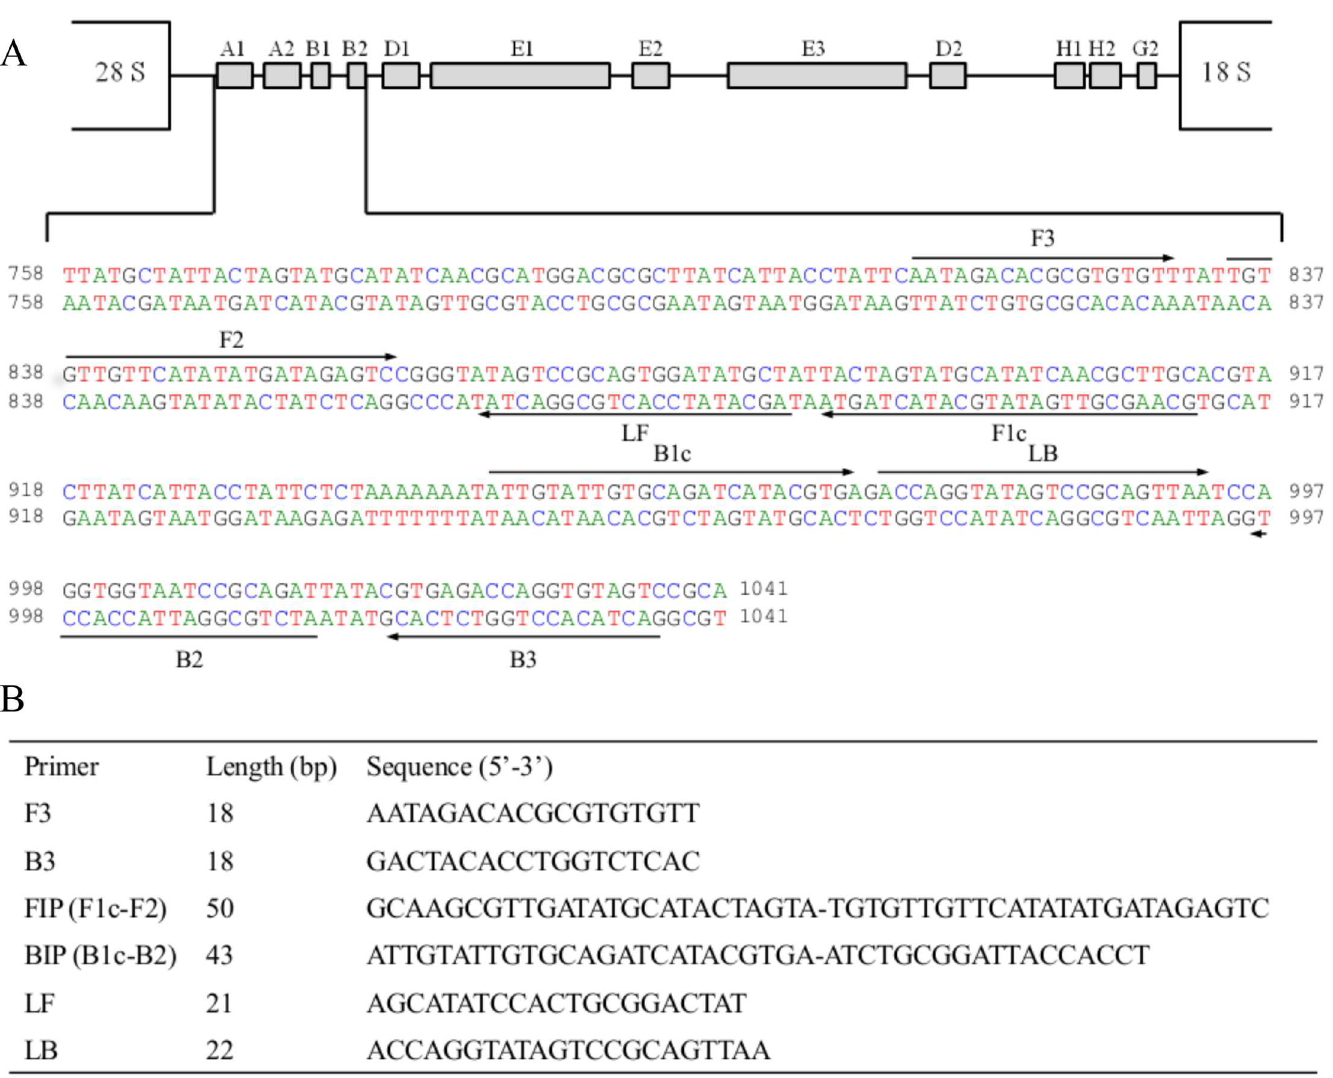
Fig 2. LAMP primer set targeting the selectedsequence (GenBank Accesion. No. AJ223842) for ribosomal intergenic spacer 28S-18Sribosomal RNA gene S . mansoni DNA region amplification. (A) The locationof the LAMP primers within the selectedsequenceis shown. Arrows indicate the directionof extension.(B) Sequenceof LAMP primers: F3, forward outer primer; B3, reverse outer primer; FIP, forward inner primer (comprising F1c and F2 sequences); BIP, reverse inner primer (comprising B1c and B2 sequences); LF, loop forward primer; LB, loop reverse primer.